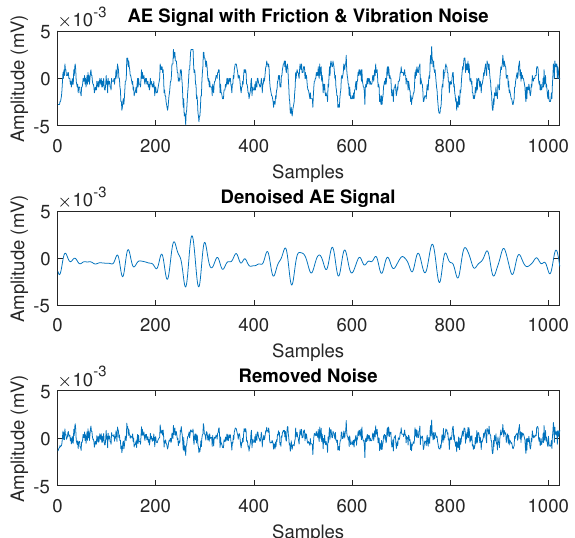
Figure 6. Comparison among frictional and vibrational noisy AE signal, the signal after denoising and estimated